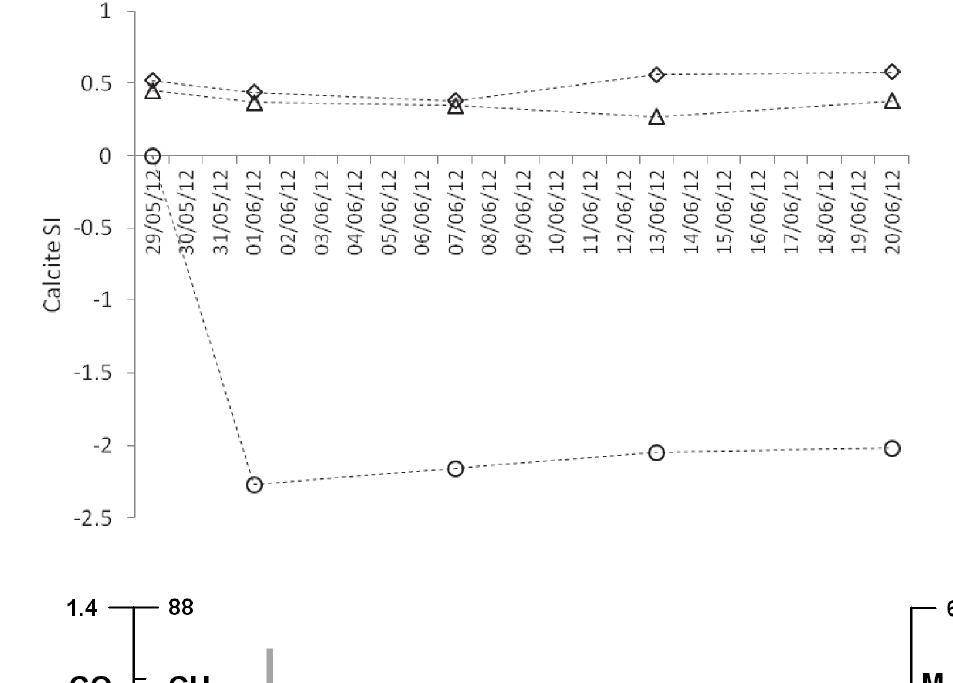
; empty circles, CH . 2 4